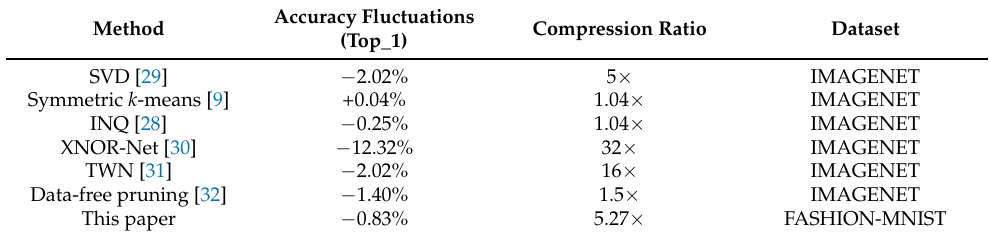
Table 3. Loss of precision and compression ratios of different compression methods in